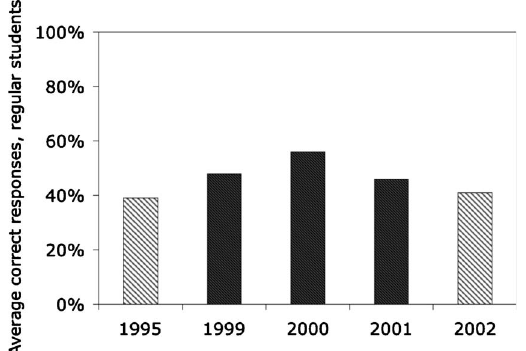
FIG. 2. Average correct responses for the Regular students, pre- instruction, in 1995, and from 1999 to